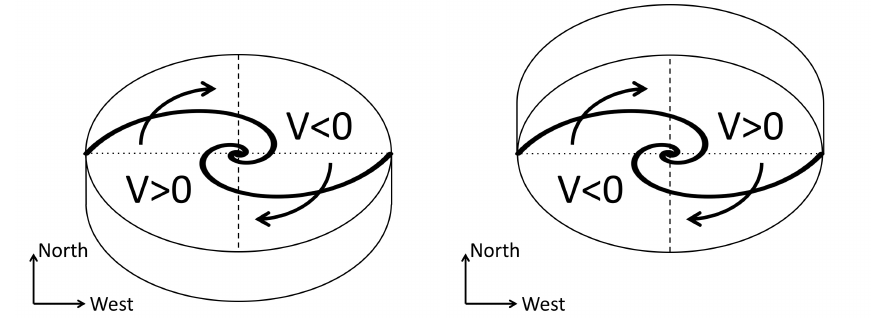
Figure 2. Determination of nearside of disk based on assumption of trailing spiral